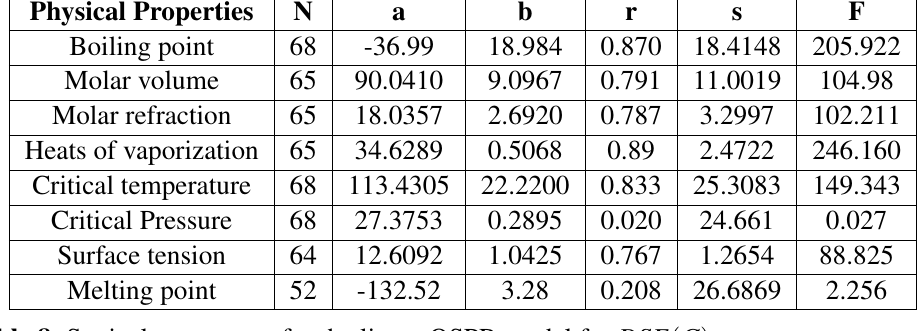
Table 8. Statical parameters for the linear QSPR model for DSE ( G ) .